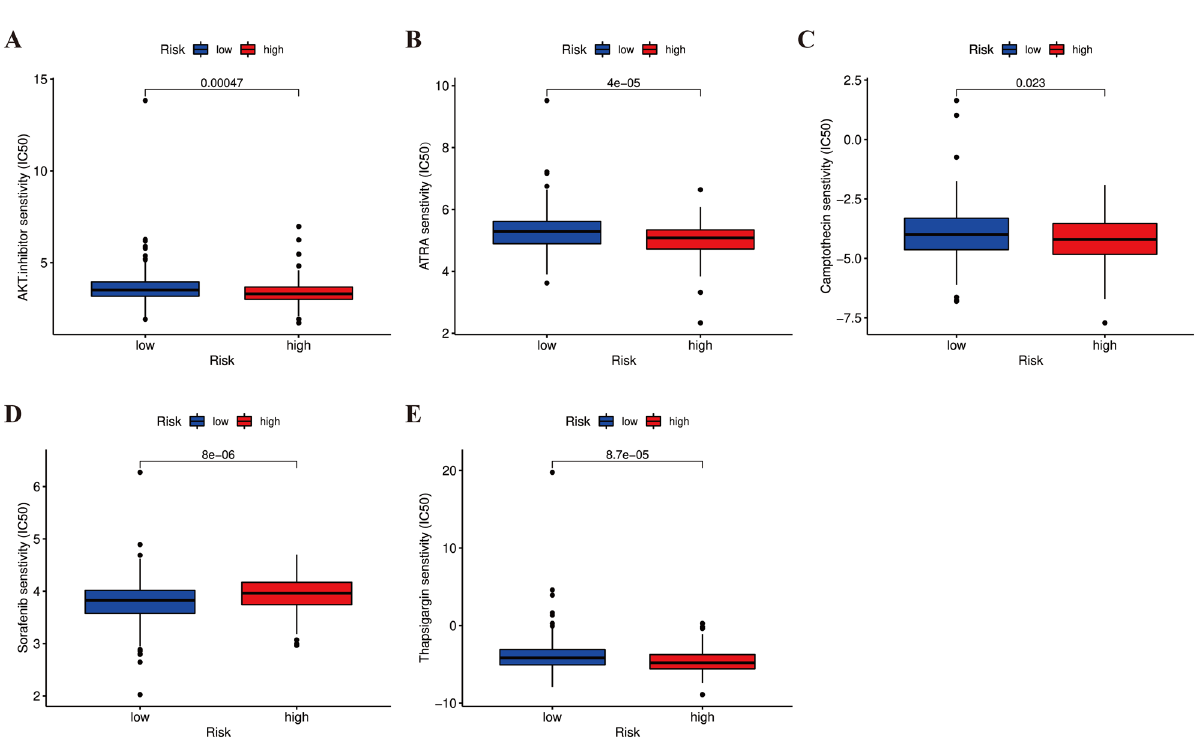
Figure 13. Drug sensitivity and potential therapeutic agents in high- and low-risk groups. AKT inhibitors ( A ), all-trans retinoic acid ( B ), camptothecin ( C ), sorafenib ( D ), and thapsigargin ( E